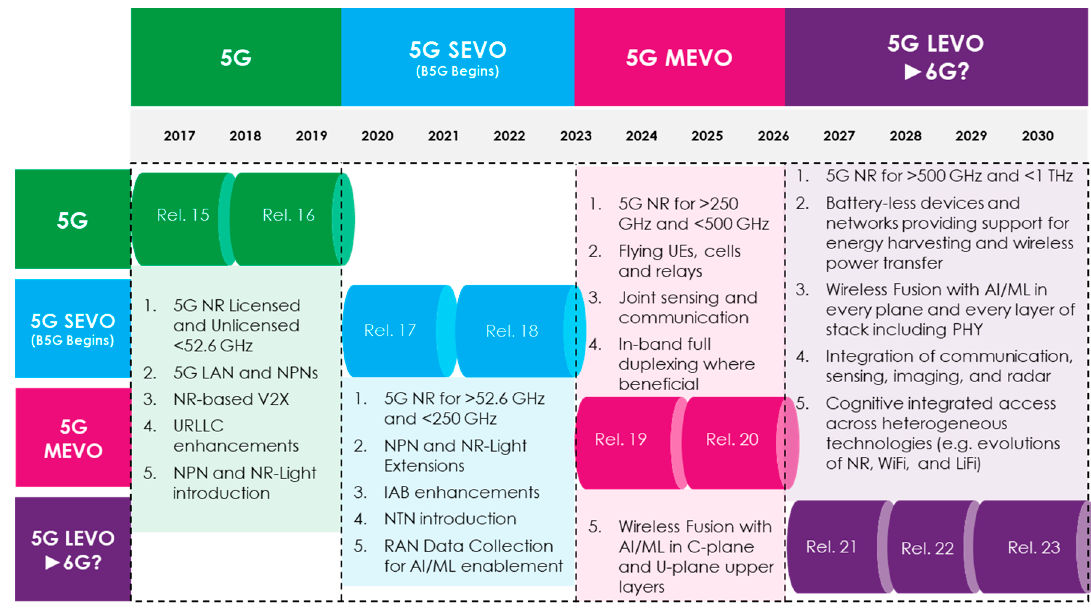
Figure 2. Baseline Technology Roadmap from a 3GPP-Release viewpoint.